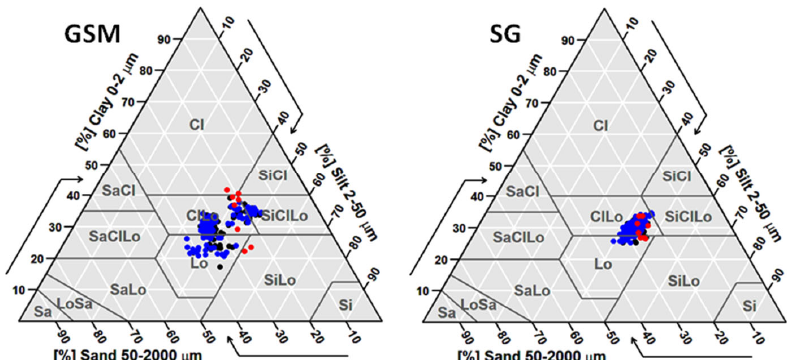
Figure 2. Soil type distribution derived from GlobalSoilMap ( left ) and SoilGrids ( right ) products based on the United States Department of Agriculture (USDA) classification system. The red, black, and blue circles respectively correspond to fields in the 2013, 2014, and 2015 seasons.